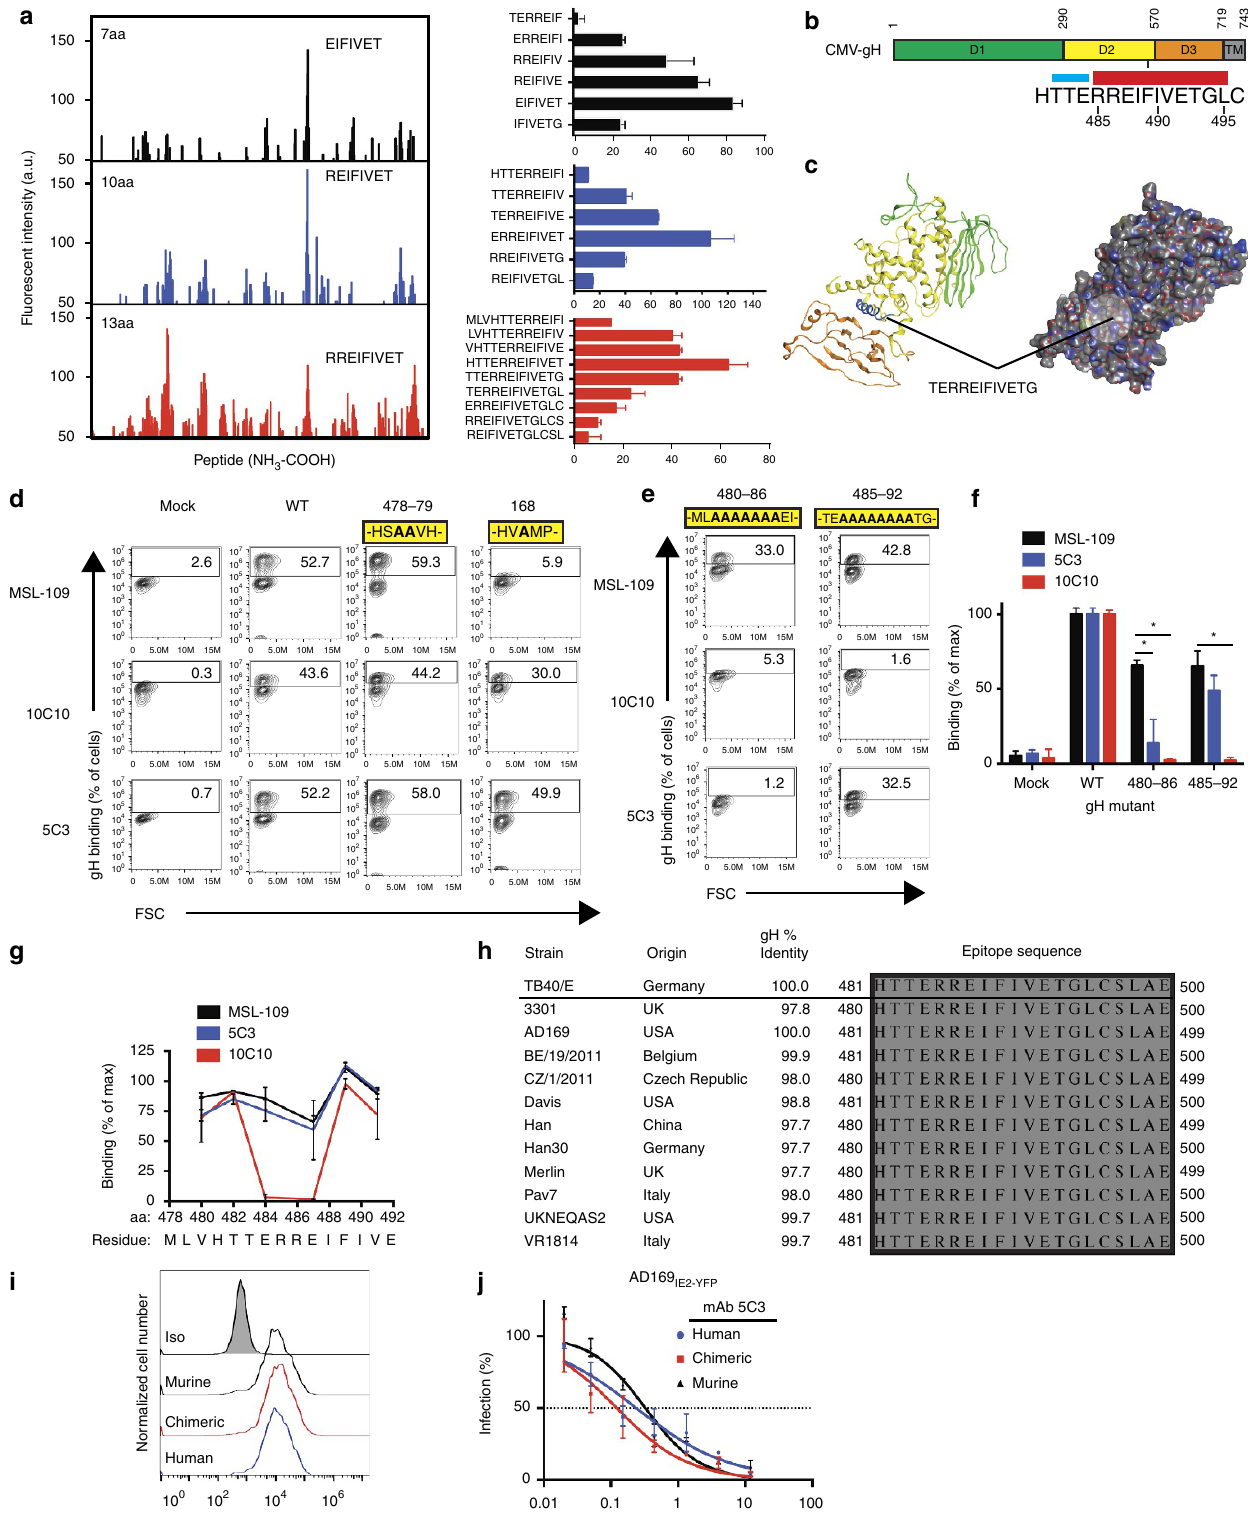
RREIFIV REIFIVE EIFIVET IFIVETG